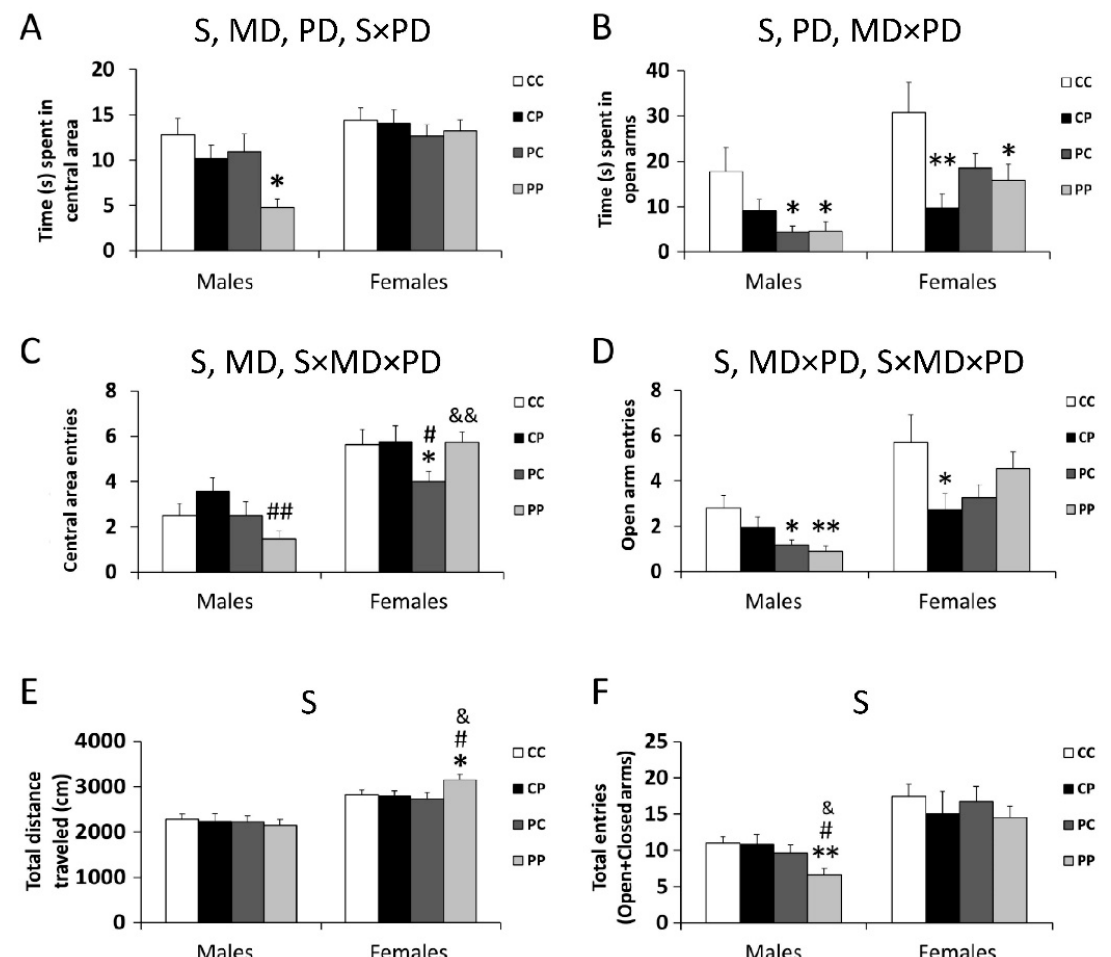
Figure 1. Effect of maternal and/or offspring exposure to a free-choice palatable (P) diet on anxiety-related behavior in the elevated plus maze test and in the open field test: time spent in central area of the open field test ( A ), time spent in open arms of the elevated plus maze test ( B ), number of entries into central area of the open field test ( C ), number of entries into the open arms of the elevated plus maze test ( D ), total distance traveled in the open field test ( E ), total entries into the open and closed arms of elevated plus maze test ( F ). Data are expressed as the mean ± S.E.M. ( n = 6). Student’s t test: * / ** p < 0.05/0.01 vs. CC males or CC females; #/## p < 0.05/0.01 vs. CP males or CP females; &/&& p < 0.05/0.01 vs. PC males or PC females. MD: maternal diet effect; PD: postnatal diet effect; SxPD: sex and postnatal diet interaction; MDxPD: maternal and postnatal diets interaction; SxMDxPD: sex, maternal diet and postnatal diet interaction.